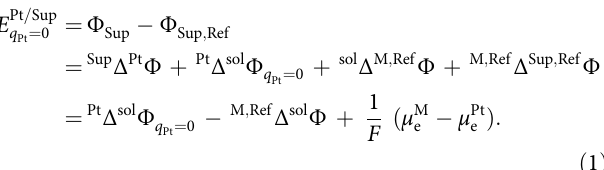
Fig. 1 Electrostatic conditions around a supported Pt nanoparticle in electrochemical environment. a Schematic cell used to derive Eq. (1) with Pt/ Support electrode, electrolyte, and reference electrode (Ref). For ease of derivation and without loss of generality, the reference electrode metal M is considered to form a dense layer on a substrate of the same support material. The inner electrostatic potentials of different phases i are denoted by Φ i . b Interface charging at the Pt/Support electrode in a strongly screening electrolyte, i.e. for w dl ≪ d Pt , at the PZC E Pt = Sup q nanoparticle surface in contact with the electrolyte. Negative ions of the electrolyte are depicted by circles with negative signs inside. EMSI charge transfer is con fi ned to the direct support – Pt interface, and it closes the “ gap ” in the electrochemical double layer of the support at the place of the Pt nanoparticle. The external Pt nanoparticle surface is screened by the strong electrolyte from the support interface, and thus its PZC is the same as for an unsupported Pt